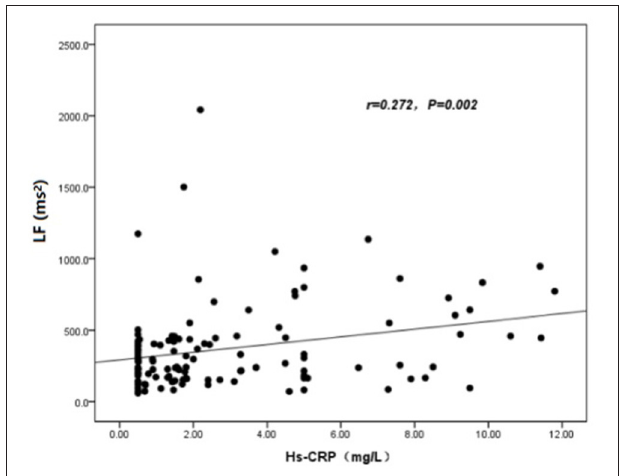
FIGURE 2 | Association analysis between hs-CRP and